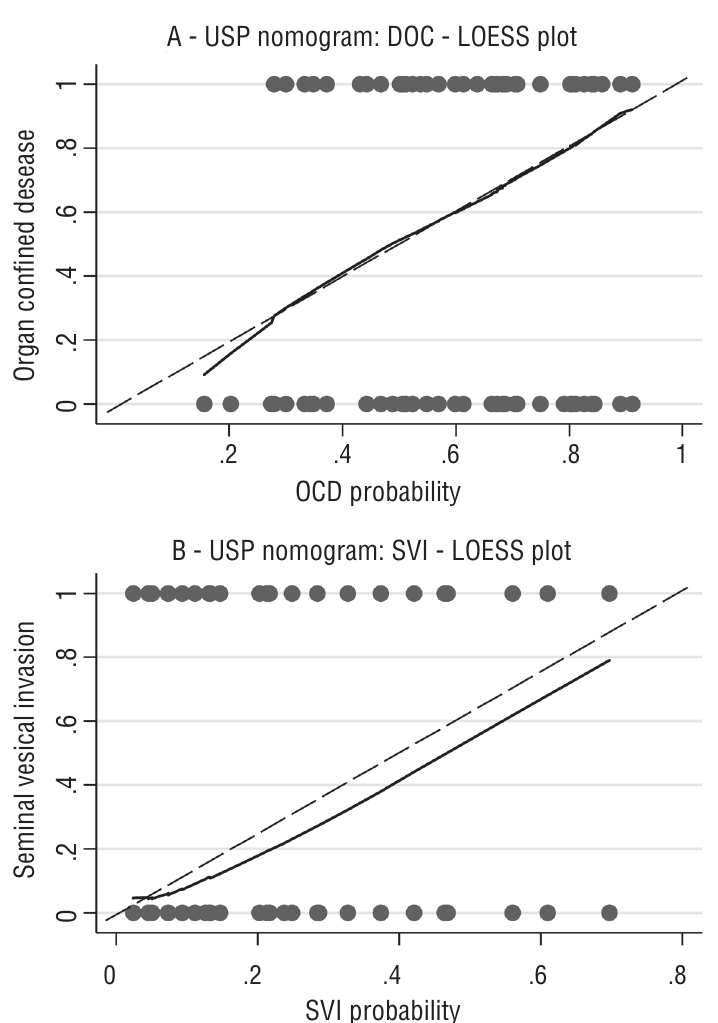
Figure 4 - LOESS curves probability distribution for OCD and SVI. A - USP nomogram: DOC - LOESS